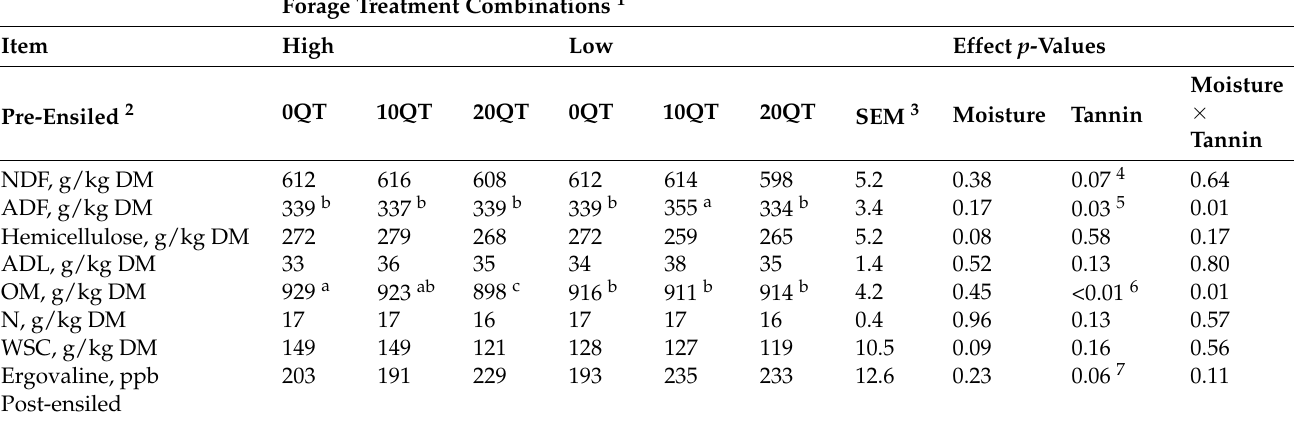
Table 1. Pre- and post-ensiled forage chemical components of tall fescue ensiled in laboratory silos at different moistures without quebracho tannin (0QT) or with tannin at 10 (10QT) or 20 (20QT) g/kg total silage